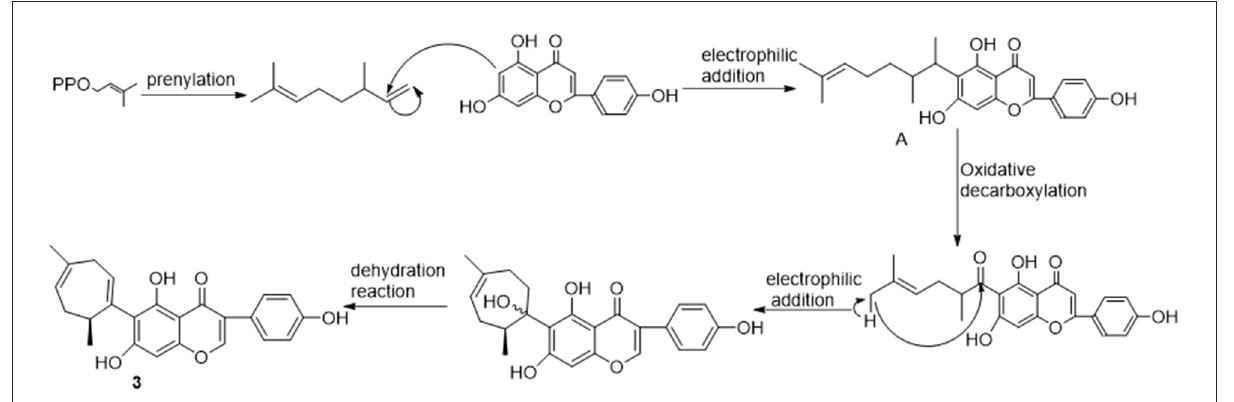
FIGURE3 Hypothetical biosynthetic pathways of compound 3